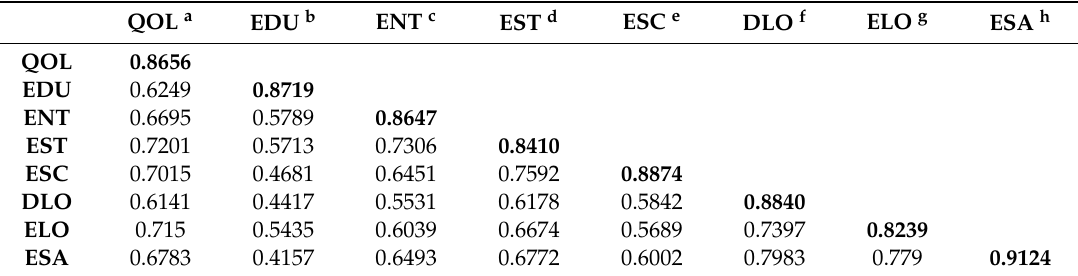
Table 5. Discriminant validity assessment